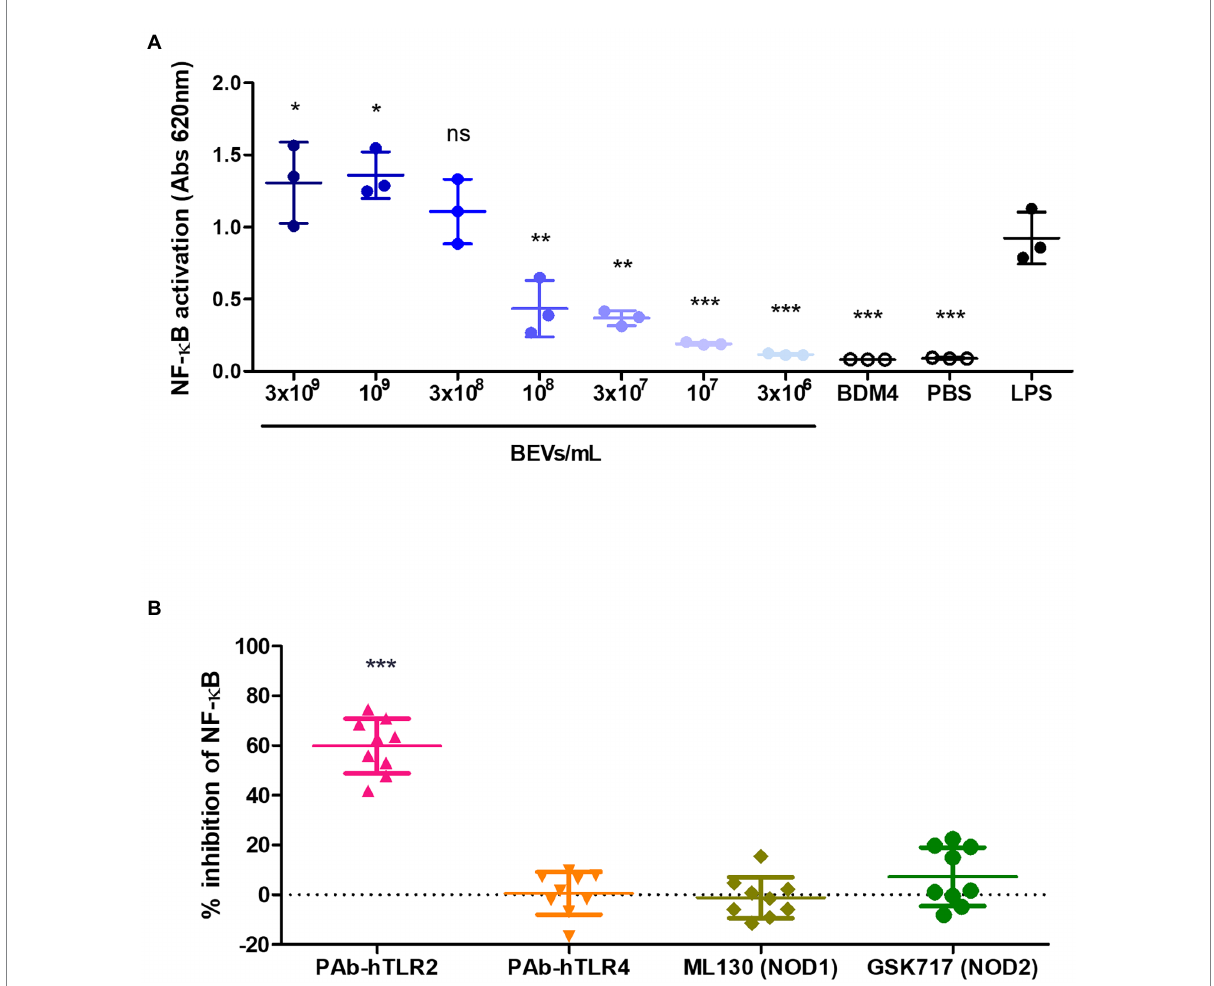
FIGURE 3 Mediators of Bt BEV-monocyte/macrophage interaction identified using THP1-Blue monocytes. (A) THP-1 cells were incubated with a range of Bt BEV concentrations or with Bt growth media (BDM4), PBS or LPS for 24 h prior to assessing level of NF-kB activation. Statistical analysis was performed using LPS as the reference group. (B) THP-1 cells were pre-incubated with optimal concentrations of TLR2, TLR4, NOD1 or NOD2 inhibitors prior to the addition of Bt BEVs and subsequent assessment of NF-kB activation. Graphs depict mean ± SD values. ns: p > 0.05; * p < 0.05; ** p < 0.01; *** p <